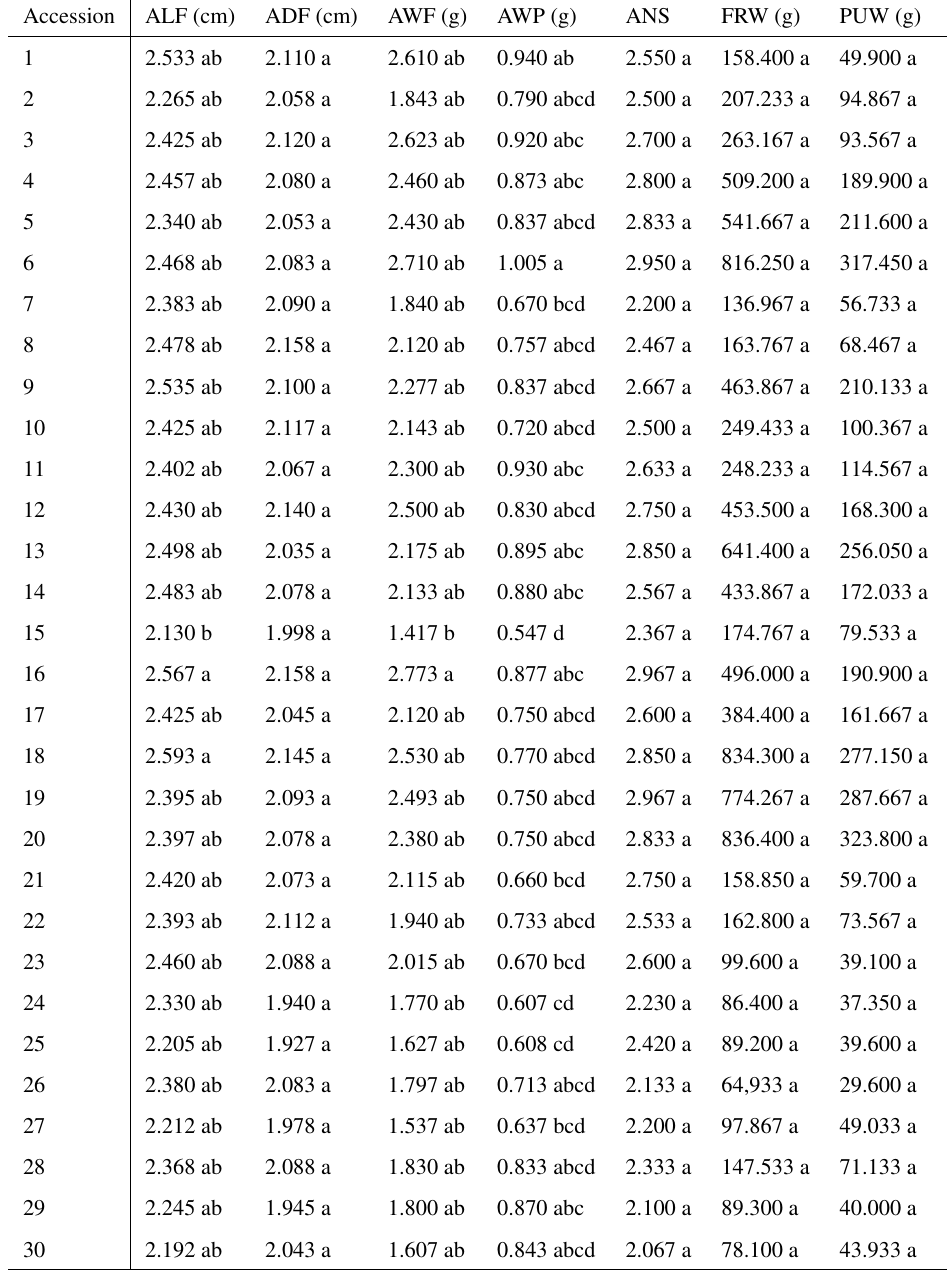
Table 4. Results of Newman Keuls'means separation test on fruits